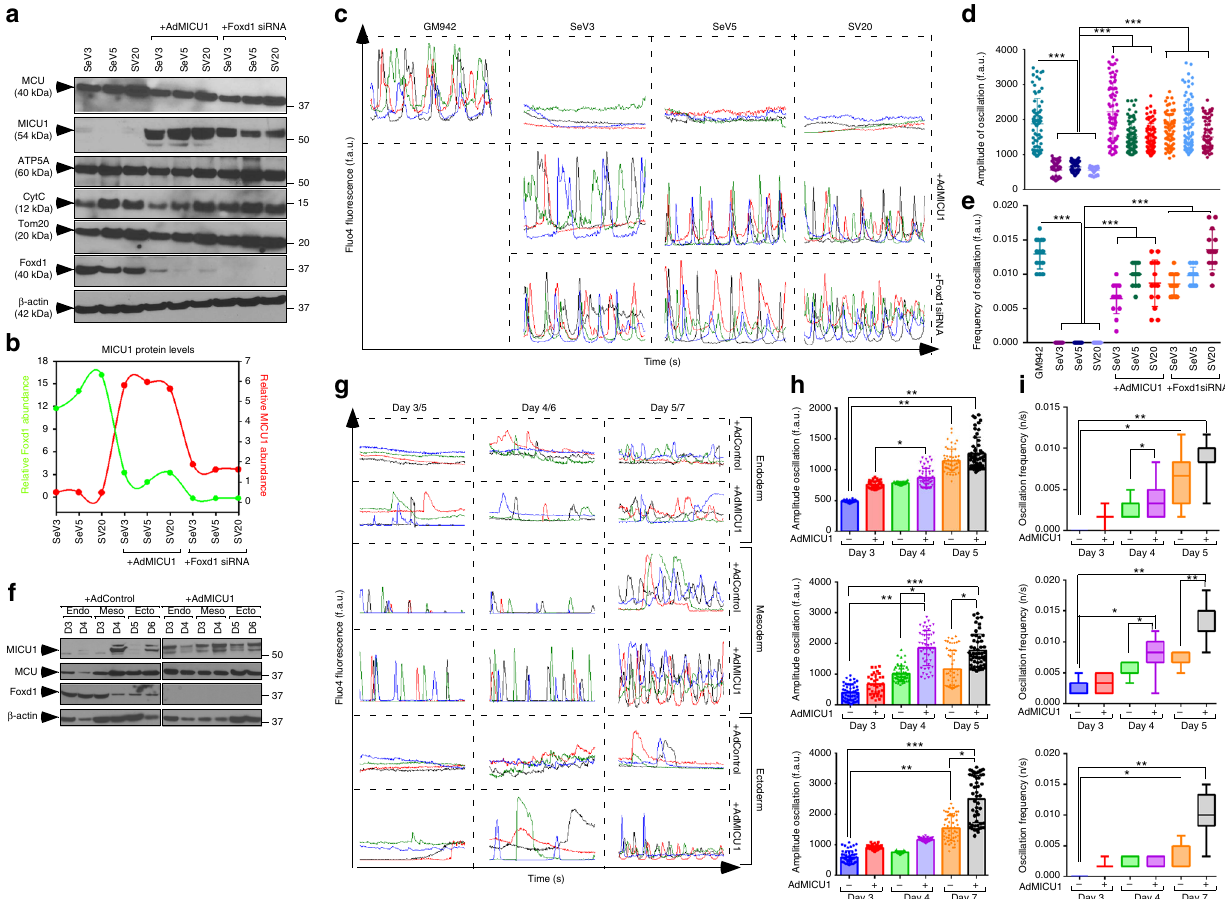
Fig. 4 Reconstitution of MICU1 in hiPSCs establishes i Ca 2 + transients and modulates lineage-speci fi c cell differentiation. a Representative western blot for lysates from hiPSCs with and without MICU1 expression. The western blots were probed with antibody speci fi c for MICU1, MCU, ATP5A, Cytochrome C, Foxd1, Tom20, and β -actin. b Quanti fi cation of relative protein abundance of Foxd1 and MICU1. c Traces of spontaneous cytosolic Ca 2 + oscillations in control fi broblasts and hiPSCs with and without MICU1 expression. Intact cells were loaded with fl uo4 and spontaneous Ca 2 + oscillations were observed at 488 nm. d Quanti fi cation of peak fl uo-4 fl uorescence. e Quanti fi cation of the frequency of c Ca 2 + oscillations. f Representative western blot for lysates from hiPSCs induced for lineage speci fi c differentiation for the speci fi ed days with and without MICU1 expression. The western blots were probed with antibody speci fi c for MICU1, MCU, Foxd1, and β -actin. g Traces of spontaneous c Ca 2 + oscillations in hiPSCs upon induction of lineage speci fi c differentiation with and without MICU1 expression. Ca 2 + transients were measured at different days of differentiation: Day 3, 4, and 5 for endoderm and mesoderm; Day 5, 6, and 7 for ectoderm. h Quanti fi cation of peak fl uo-4 fl uorescence. i Quanti fi cation of the frequency of c Ca 2 + oscillations. Data indicate quanti fi ed peak fl uorescence/frequency of oscillation. Mean ± SEM is represented in the fi gures; ** P < 0.01, * P < 0.05, *** P < 0.001; n = 3 – 4 (One-Way Anova) individual experiments. Dots represents mean data from group of